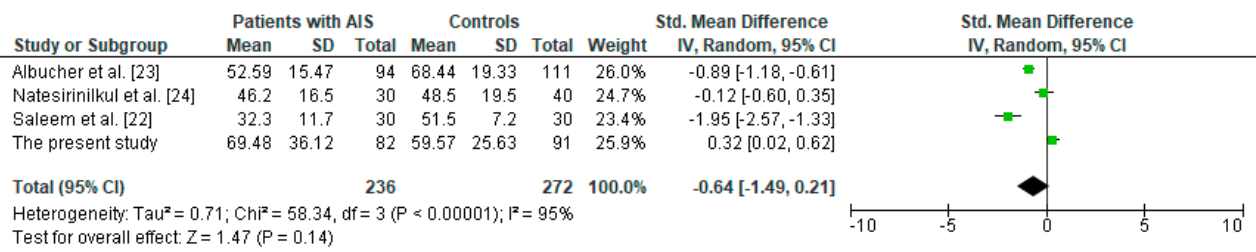
Figure 5. Forest plot for LDL level in the groups of pediatric patients with AIS and controls [22–24]. LDL—low density lipoprotein; AIS—arterial ischemic stroke; CI—confidence interval; I 2 —heterogeneity; df—degrees of freedom.